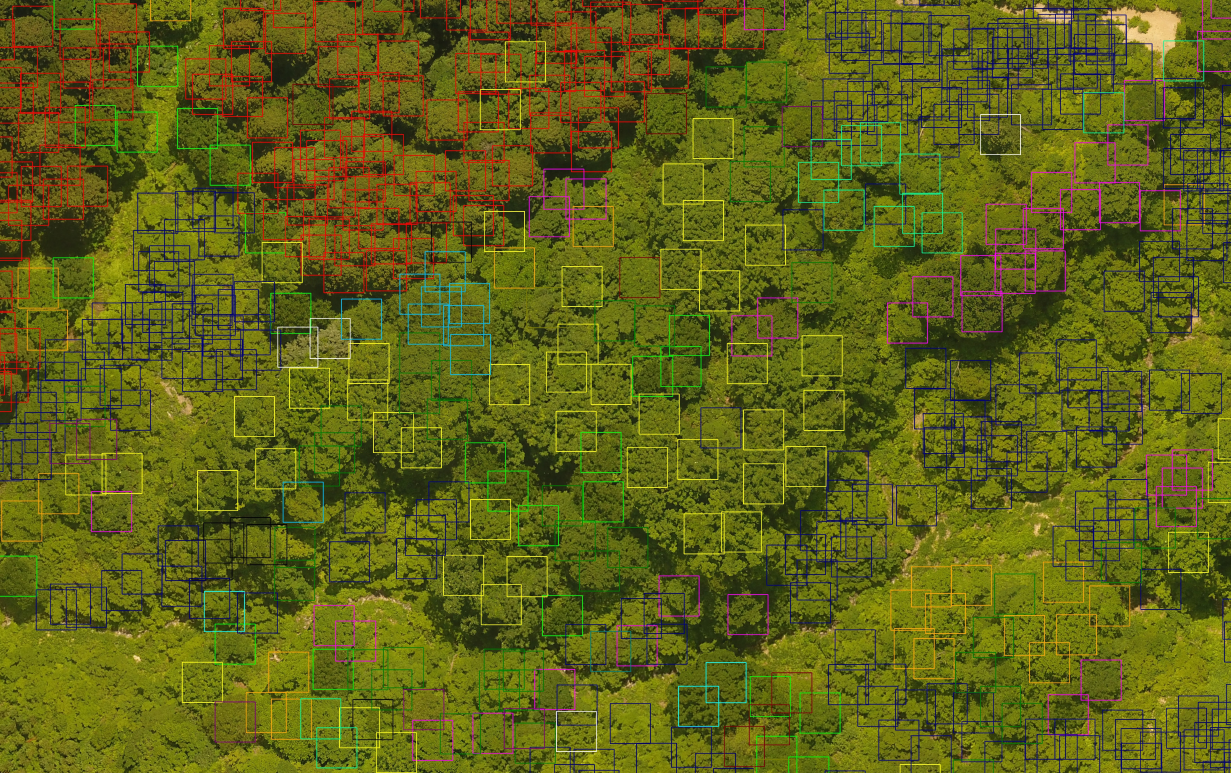
Figure 6. Example of the “Tree Detection + Image Classification for Species classification” approach. A square patch is built around each treetop. Different colored squares represent different tree species, original orthomosaic corresponding to a natural mixed forest in Tsuruoka